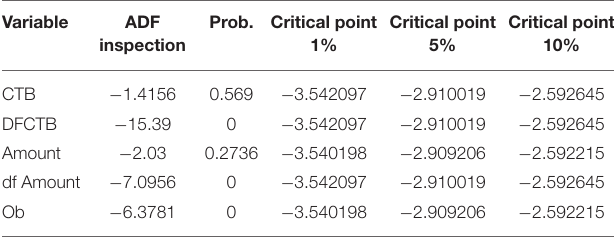
TABLE 1 | Stationary test results of a series of macroeconomic variables.